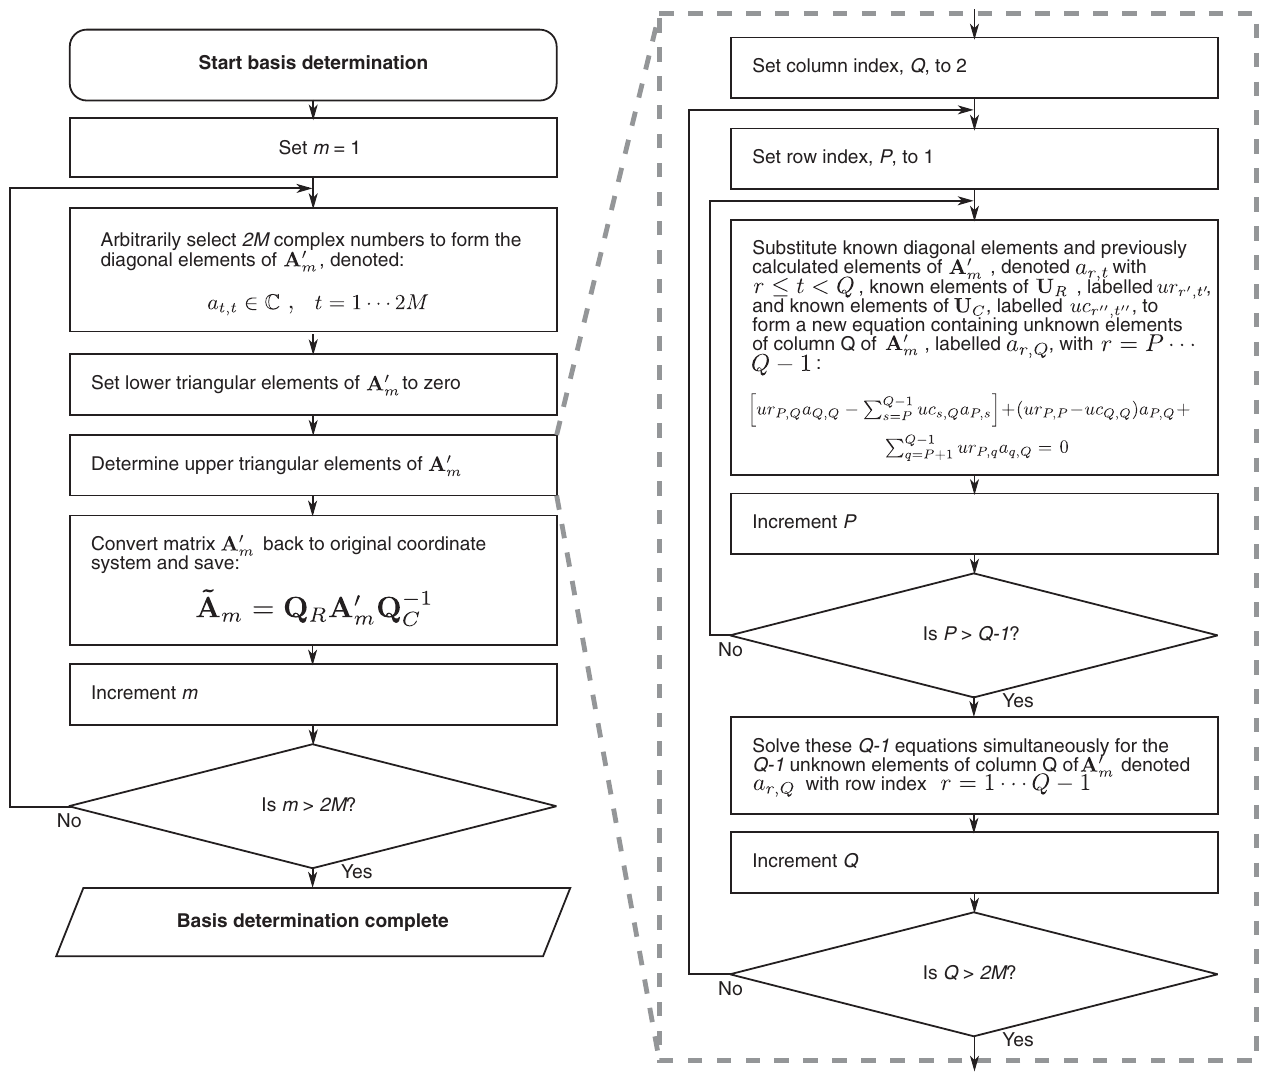
FIG. 14. Flowchart detailing the process of finding a basis for the matrix A using the zeroth-order solution